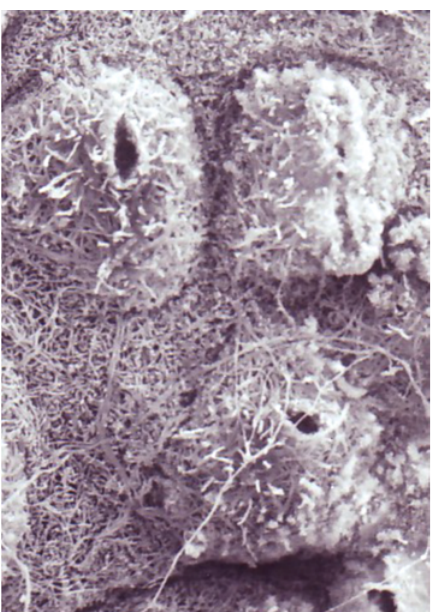
Fig. 4. Conidia of Phoma negriana , 640 x magnification. Phot. E. Król.